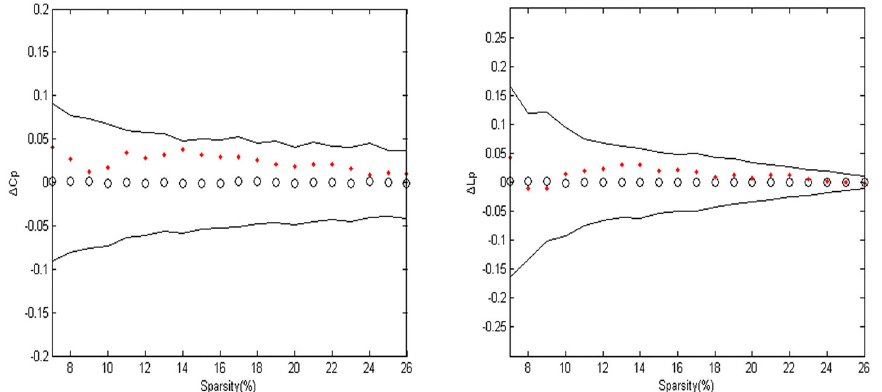
Fig 6. The left image indicates the between-group differences in clustering coefficients (Cp) and the right image indicates the between-group differences in absolute path lengths (Lp). The black open circles show the average values in each property and the black lines indicate the 95% confidence intervals of the between-group differences through 1000 permutation tests in each sparsity.